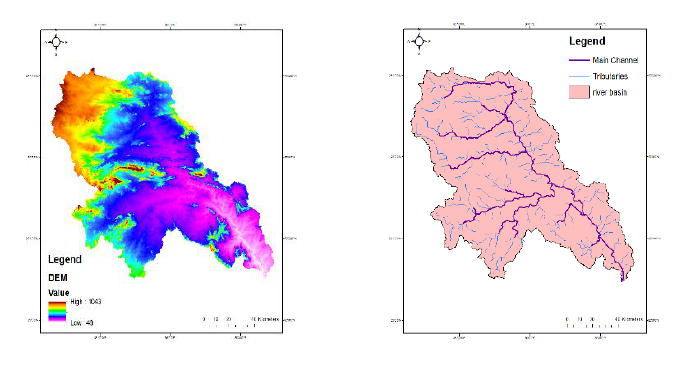
Figure 2(a): Digital Elevation Model (DEM) of upper watershed of River Subarnarekha